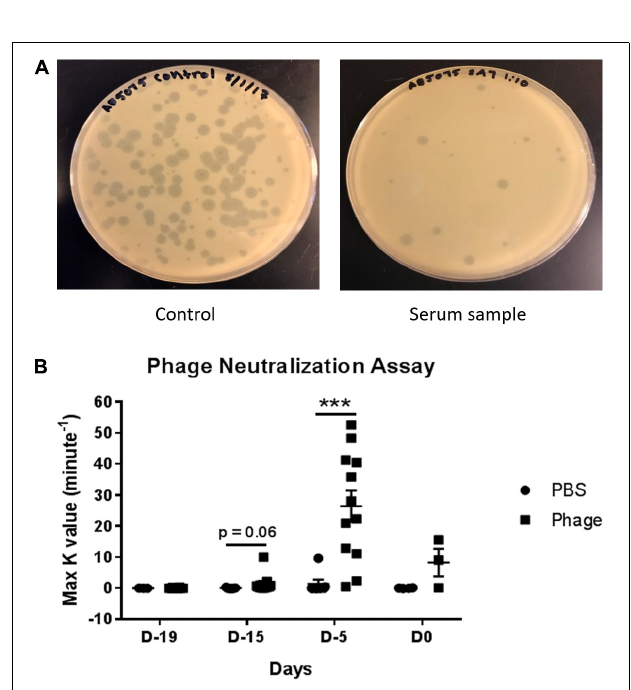
FIGURE 7 | Detection of serum neutralizing antibodies against A. baumannii phage mixture. Dilutions were made from serum collected from naïve mice given PBS (control) or phage mixture and incubated with a known titer of phage mixture (4 × 10 4 total PFU). (A) The mixtures were then added to an inoculum of AB5075 and plated in warm agar. (B) After 24 h incubation at 37 ◦ C, rate of phage neutralization was measured. N = 7 for PBS, N = 13 for Phage per time point; *** p <